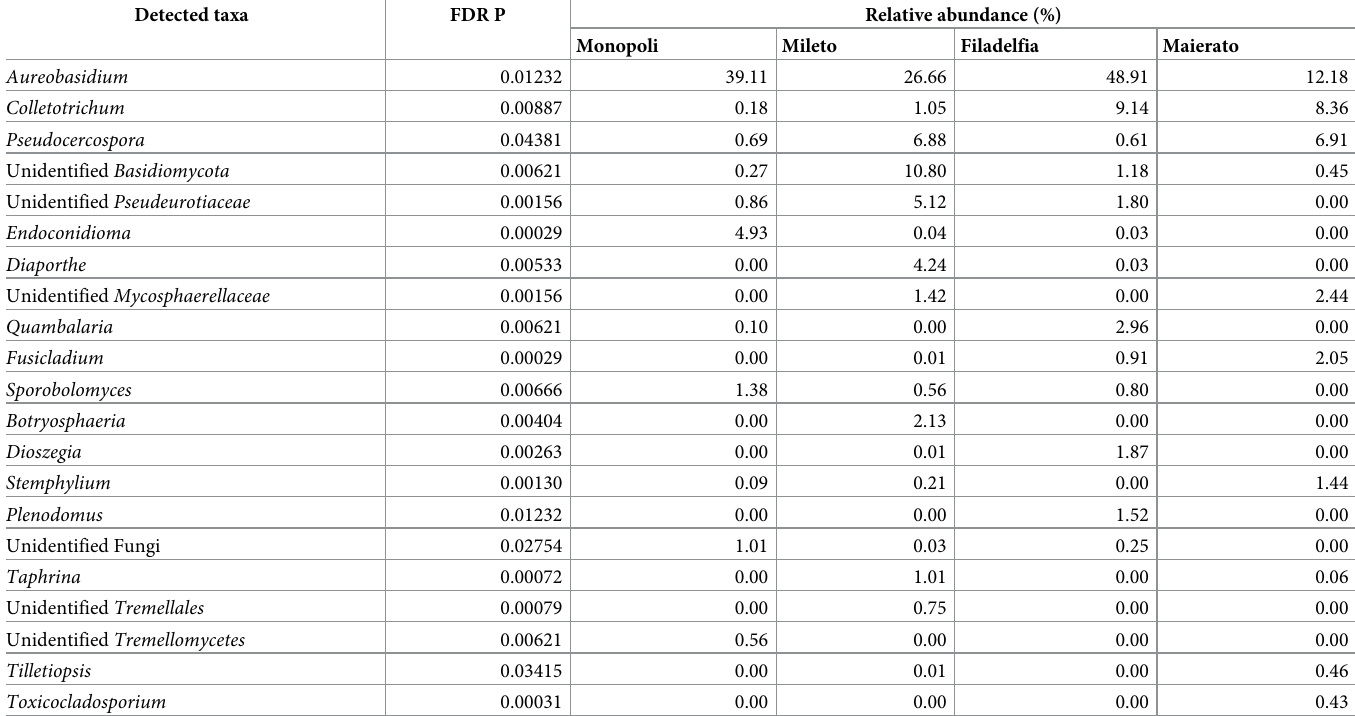
Table 3. List of fungal taxa characterized by a significantly different relative abundance (RA) between the four investigated locations. P values were calculated using nonparametric test of Kruskal-Wallis through 1000 permutations. FDR P are the P value corrected by the Benjamini-Hochberg FDR procedure. Detected taxa